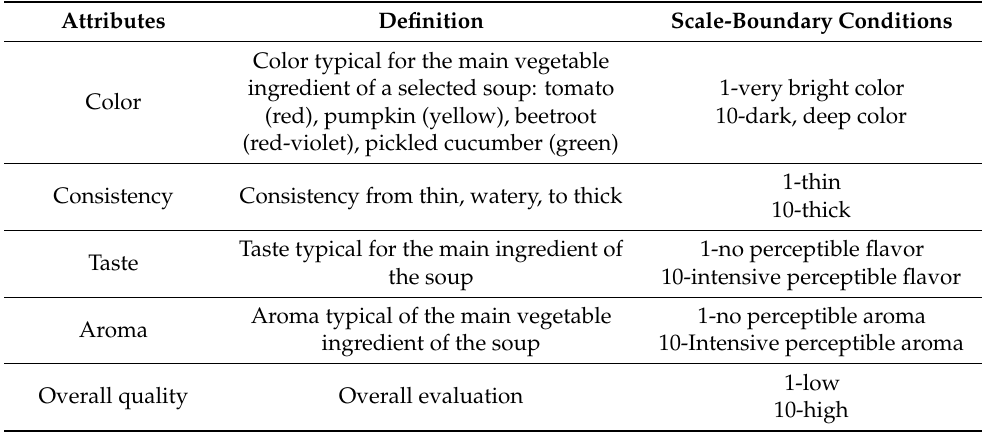
Table 2. Sensory attributes and their